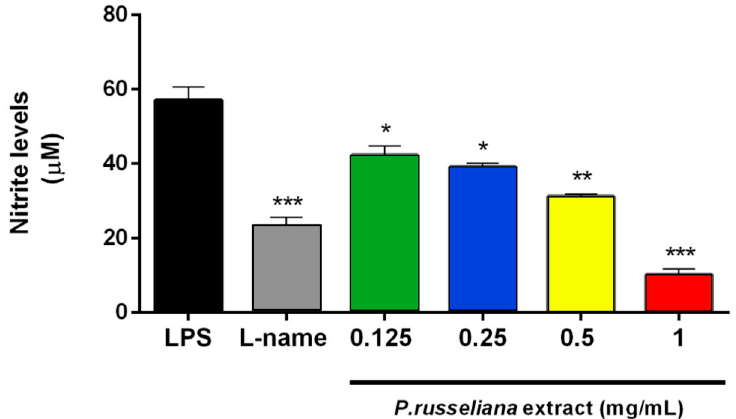
Figure 2. Effects of P. russeliana extract on nitrite production in RAW264.7 cells stimulated with 1 µg/mL of LPS. LPS: Control group treated with 1 µg/mL LPS. Statistical significances were indicated for each compound vs. LPS (* p < 0.05, ** p < 0.01, *** p < 0.001).